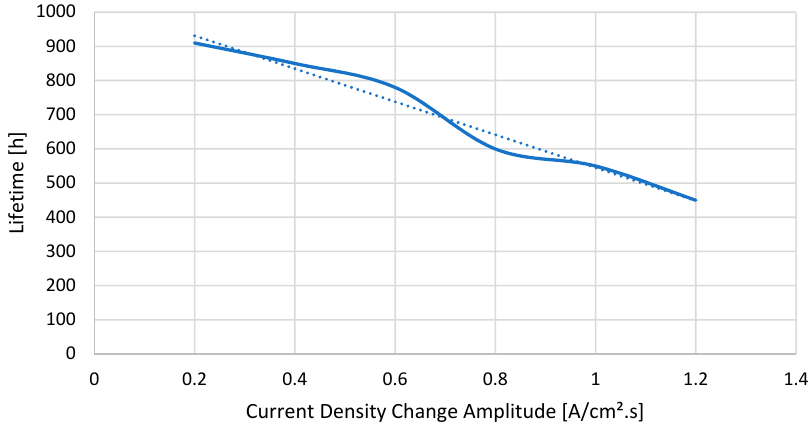
Figure 10. Load change amplitude—FC aging model.